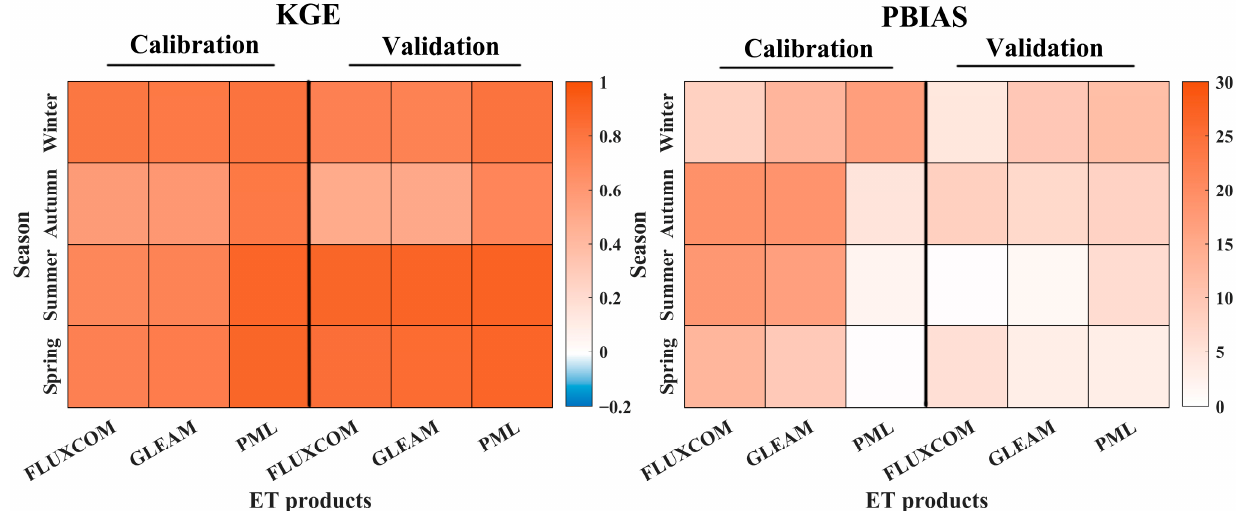
Figure 9. Comparison of KGE and PBIAS values for runoff simulations at different seasons from Scheme II.